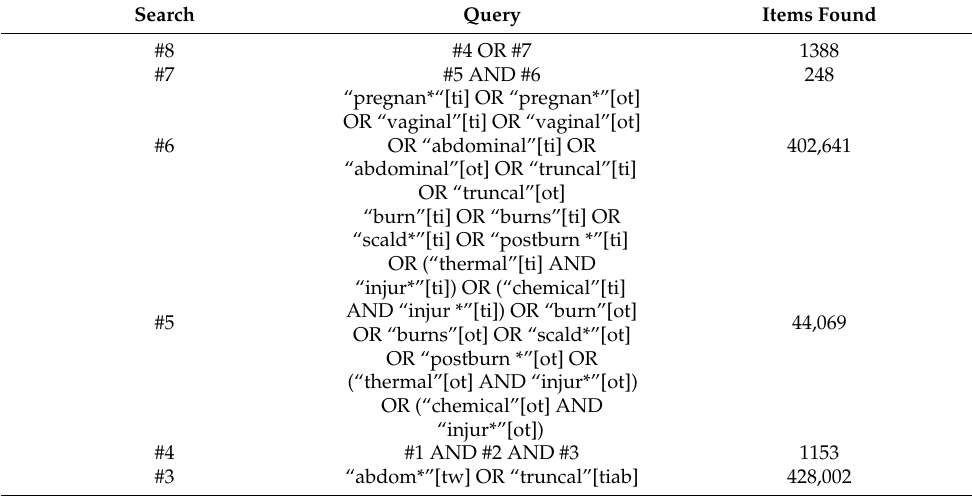
Table A1. PubMed Session Results (23 April